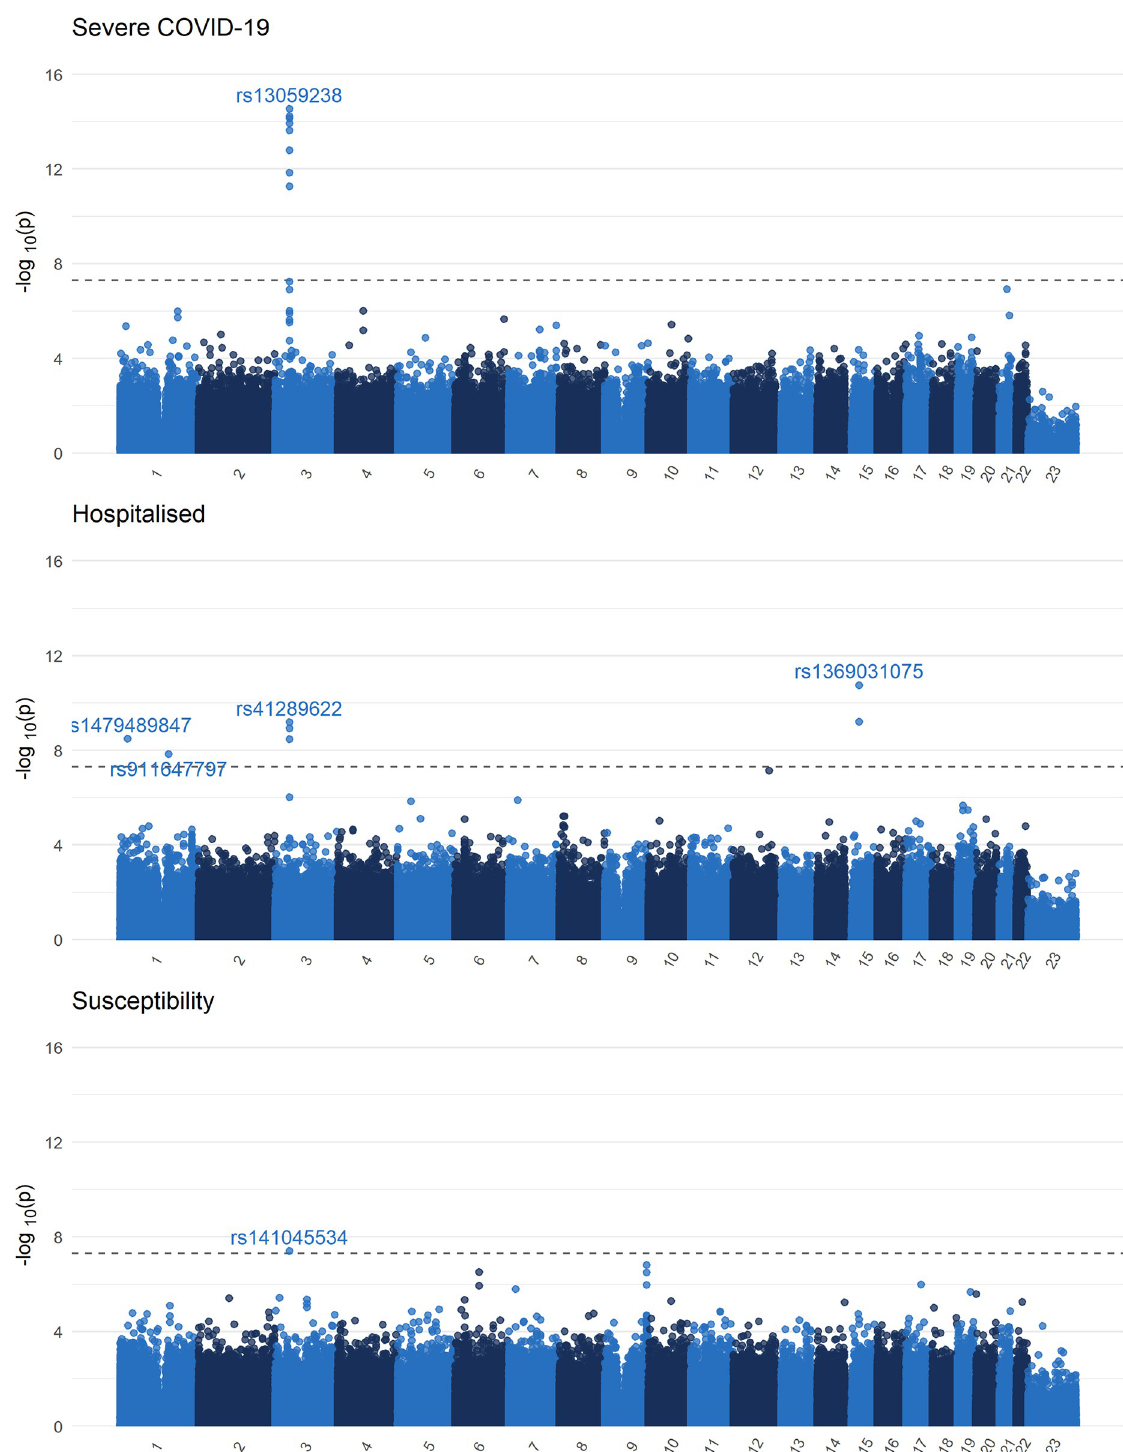
Fig 3. Single variant exome-wide association study Manhattan plot (MAF > 0.1%). QQ-plot available in the S1 Fig . Black dashed line demarcates the genome-wide significance threshold (p < 5x10 -8 ).